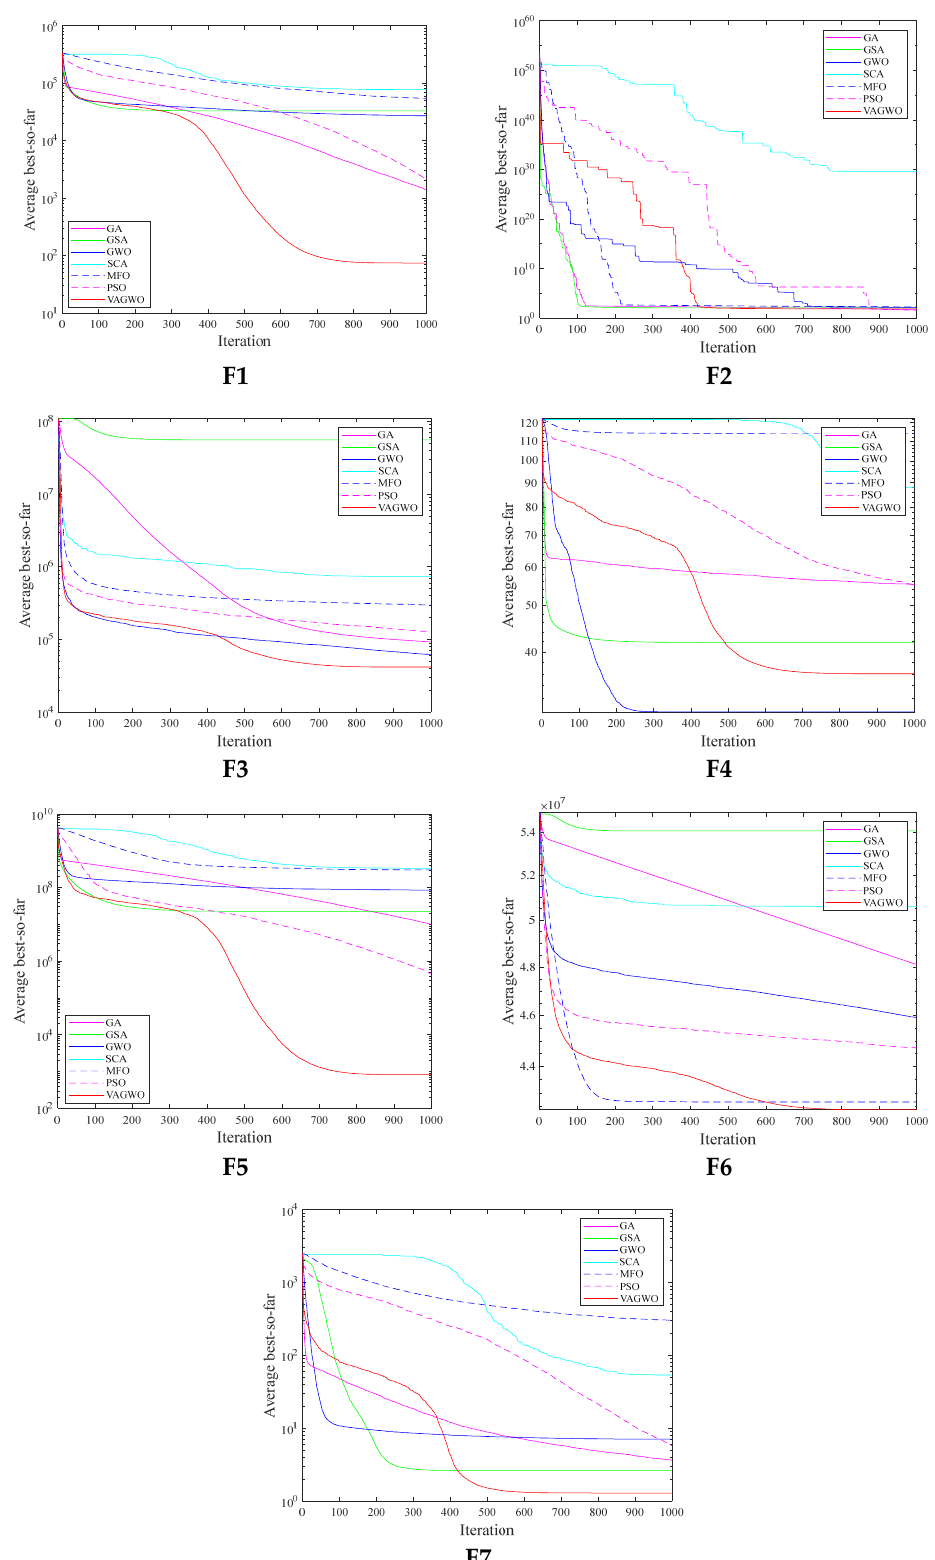
Figure 3. The convergence curves of the VAGWO and the popular algorithms for F1–F7.